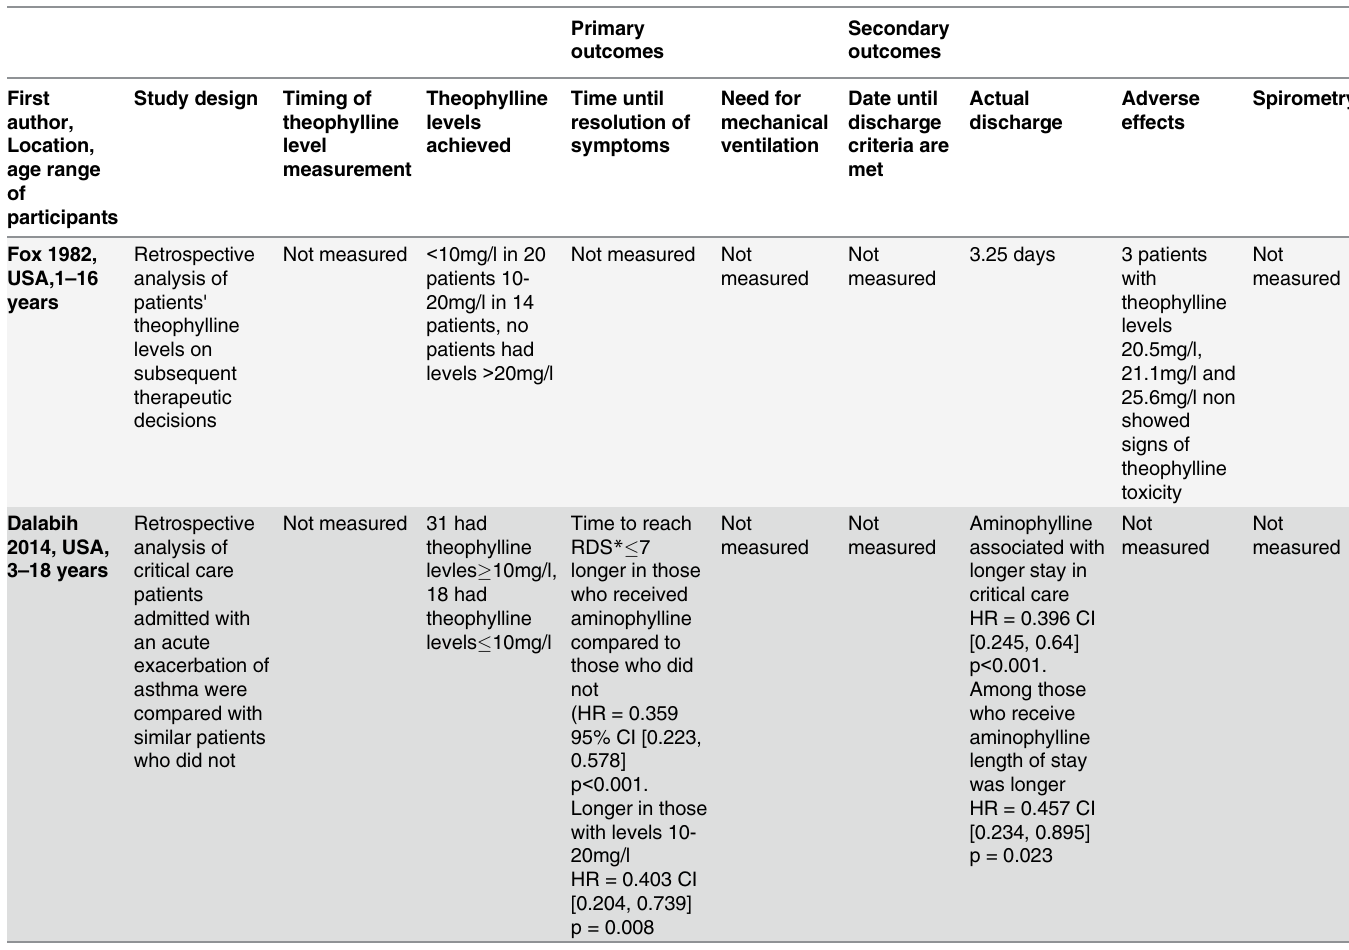
Table 4. Results of Observational